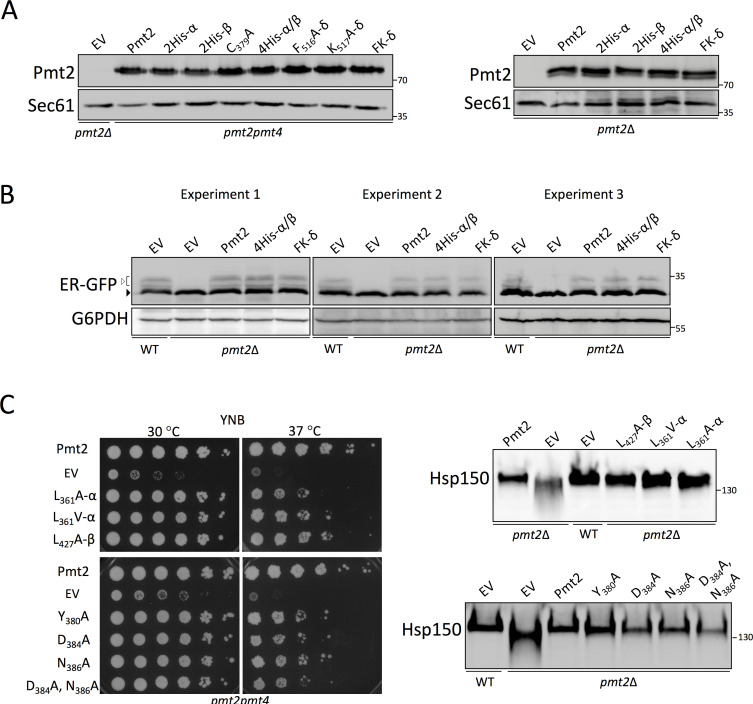
Characterization of Pmt2 alanine-exchange mutants.(A) Protein levels of Pmt2 mutant proteins. HA-epitope tagged Pmt2 wild type and alanine exchange mutant proteins were expressed in pmt2Δ or pmt2pmt4 deletion strains as indicated and grown at 30°C (left panel) and 37°C (right panel). YEp352 served as vector control (empty vector, EV). 70 μg (left panel) and 40 μg (right panel) of total membrane proteins were resolved on 8% polyacrylamide gels and analyzed by Western blot. Pmt2 proteins were detected by HA-tag directed antibody. Sec61 served as loading control. (B) O-mannosylation status of the UPOM substrate ER-GFP. Cell extracts were obtained from indicated strains, as described in Materials and methods. 50 µg (Experiment1), 75 µg (Experiment 2) or 100 µg (Experiment 3) of protein from total whole cell extracts was resolved on a 12% polyacrylamide gel and analyzed by Western blot. G6PDH served as a loading control. Black arrow (left) indicates the main ER-GFP band, white arrow (left) marks O-mannosylated ER-GFP forms. Two biological replicates (Experiment 1 and Experiment 2) and one technical replicate (Experiment 3, a technical replicate of Experiment 2) are shown. Experiment 1 is also shown in Figure 7B. (C) In vivo analysis of the functionality of different mutants in the PMT2-MIR domain. Analysis of PMT2-HA with individual alanine substitutions of leucine residues in MIRm1 (L361A; pJS4, L361V; pJS6) and MIRm2 (L427A; pJS6), and of mutants in MIRm1 covering the conserved sequence fingerprint 384-DxNN (pAS151-154). Left panel: Complementation of thermosensitive phenotype (growth on YNB; 37°C) of pmt2pmt4 mutant strains expressing either wild type Pmt2, EV (YEp352) or respective Pmt2 version with indicated mutation. Right panel: Analysis of the glycosylation status of Hsp150 in indicated strains. Enriched protein fractions were resolved on 8% polyacrylamide gels and analyzed by Western blot decorated with Hsp150-HA tag directed antibodies. In all panels, the position of the molecular weight marker is indicated on the right.